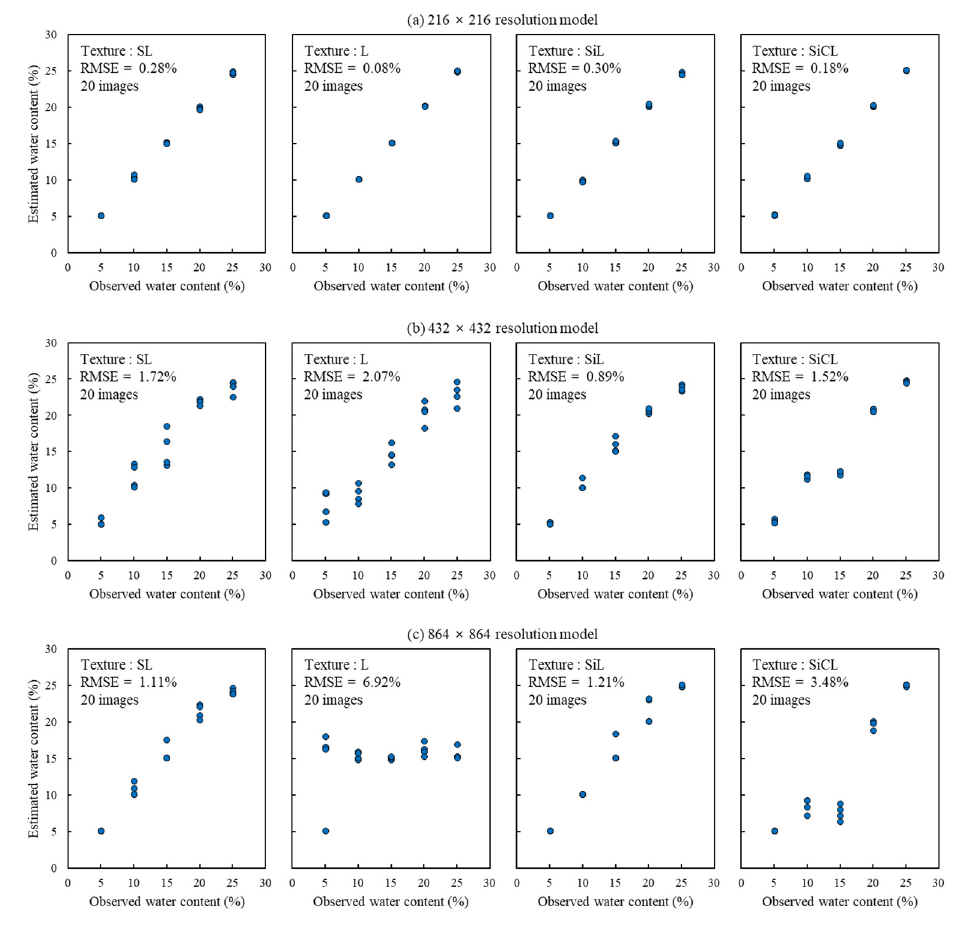
Figure 12. Quantitative results of soil water content prediction by the convolutional neural network model.